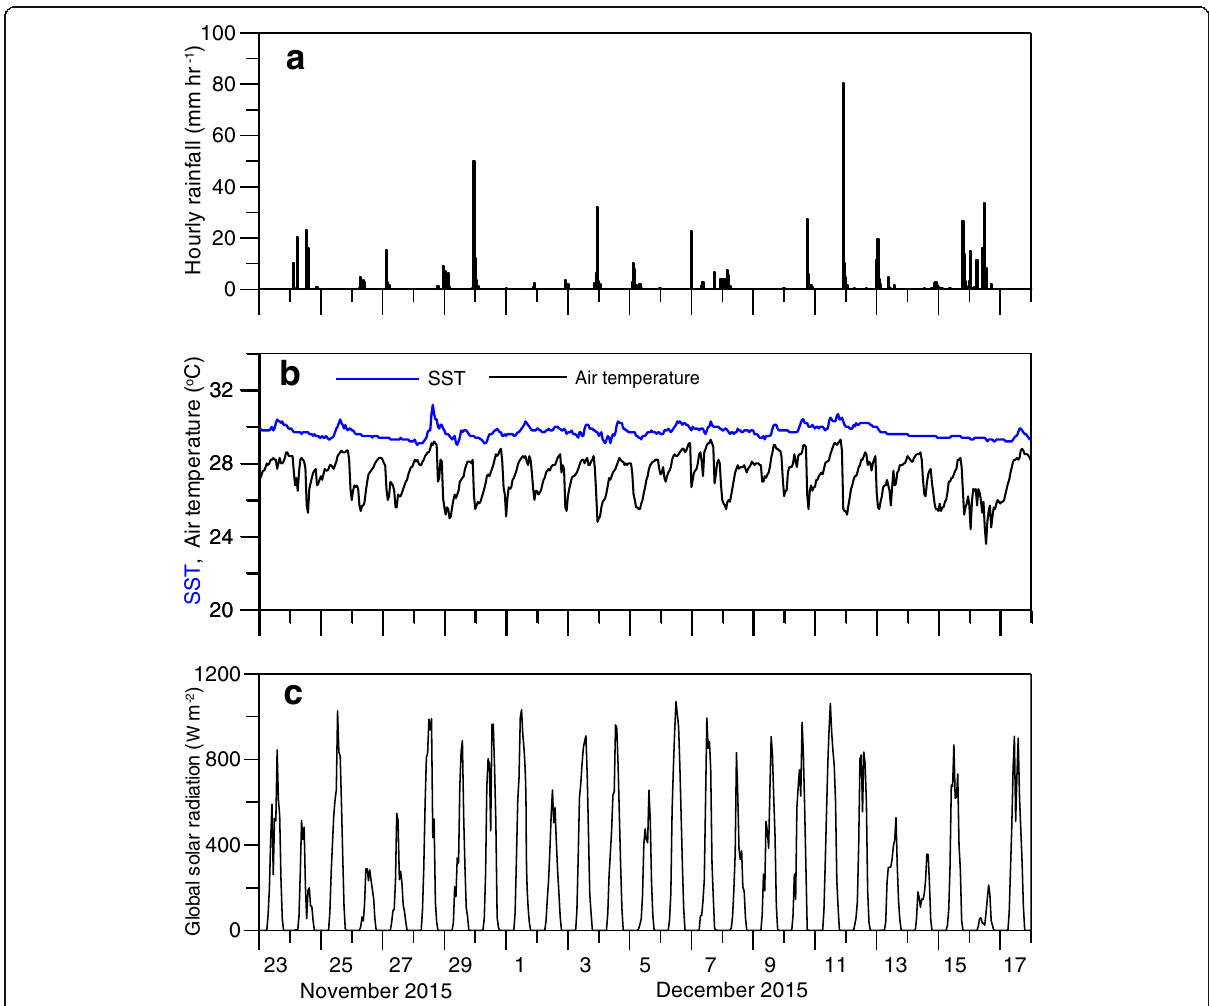
Fig. 4 Time series of a hourly total rainfall, b hourly averaged sea surface and sea air temperature (depth=5 m), and c hourly averaged global solar radiation observed by the research vessel Mirai. Stationary ship observations were carried out at 4°04 ′ 00 ″ S 101°54 ′ 00 ″ E, 50 km off the western coast of Sumatra Island from 23 November to 17 December 2015. The tick marks in the abscissa indicate 00 LT for each of the days within the time period